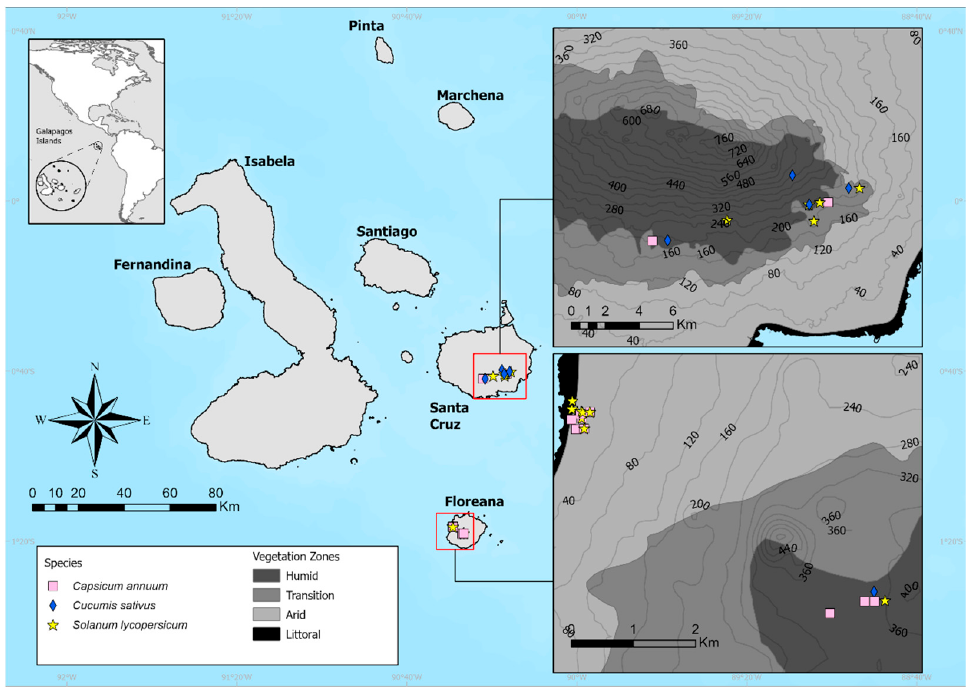
Figure 6. GPS coordinates where the farms from Santa Cruz and Floreana island are located, the map displays the agriculture zones within islands also the type of crop that each farm produced. Floreana is the smallest inhabited island in the Galapagos archipelago and has a population of about 150 people [39,40]. Freshwater is very limited on the island. During the dry season, it is common to have water restrictions and consumption cuts. The population relies primarily on three aquifers with water flows that fluctuate seasonally according to rainfall [41]. Agricultural activity is carried out in the traditionally-called transition zone and the humid area. However, some farmers and families are settled in Floreana island’s arid zone and rely on small familiar orchards for food. Experiments in Floreana were carried out primarily near the town in the island’s dry area (15 to 24 m.a.s.l.). Two producers were in the humid agricultural zone (337 to 364 m.a.s.l.).